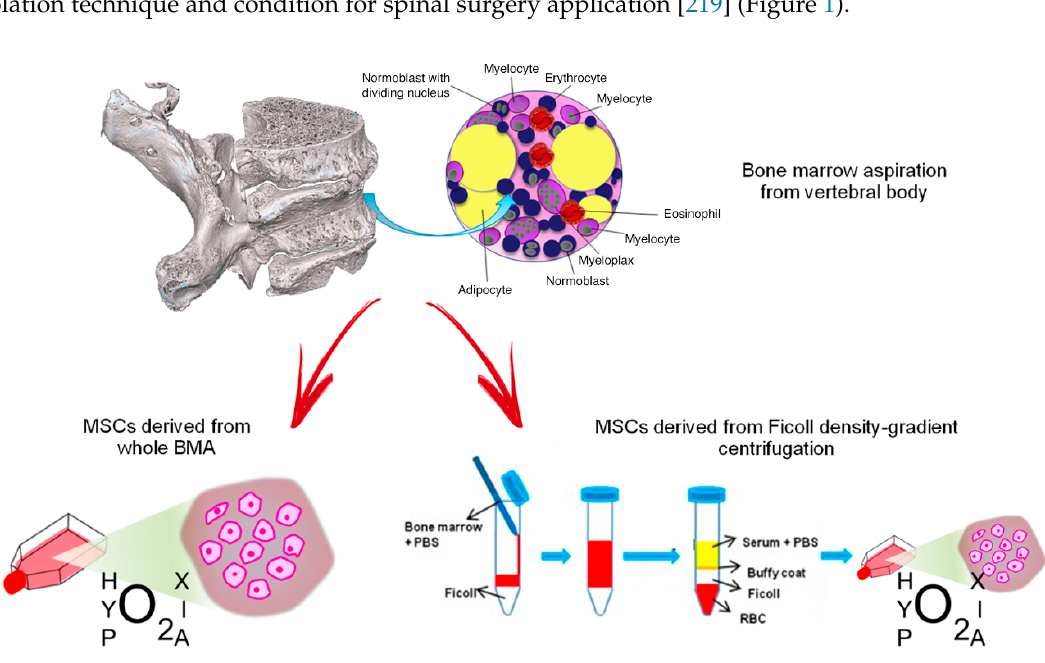
Figure 1. MSCs derived from vertebral bone marrow aspiration: culture of whole BMA or isolation of MSCs from density-gradient centrifugation. Red arrows indicate the two different processes to obtain MSCs from vertebral bone marrow aspirate (BMA): on the left, MSCs derived from whole BMA are cultured in hypoxic conditions; on the right, MSCs are isolated from BMA by Ficoll density-gradient centrifugation and they are cultured in hypoxic conditions. Blue arrows indicate the passages to obtain isolation of MSCs from BMA by Ficoll density-gradient.